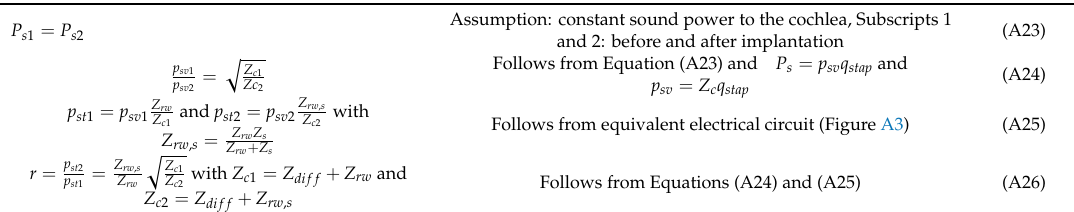
intracochlear acoustic receiver (ICAR) in the scala